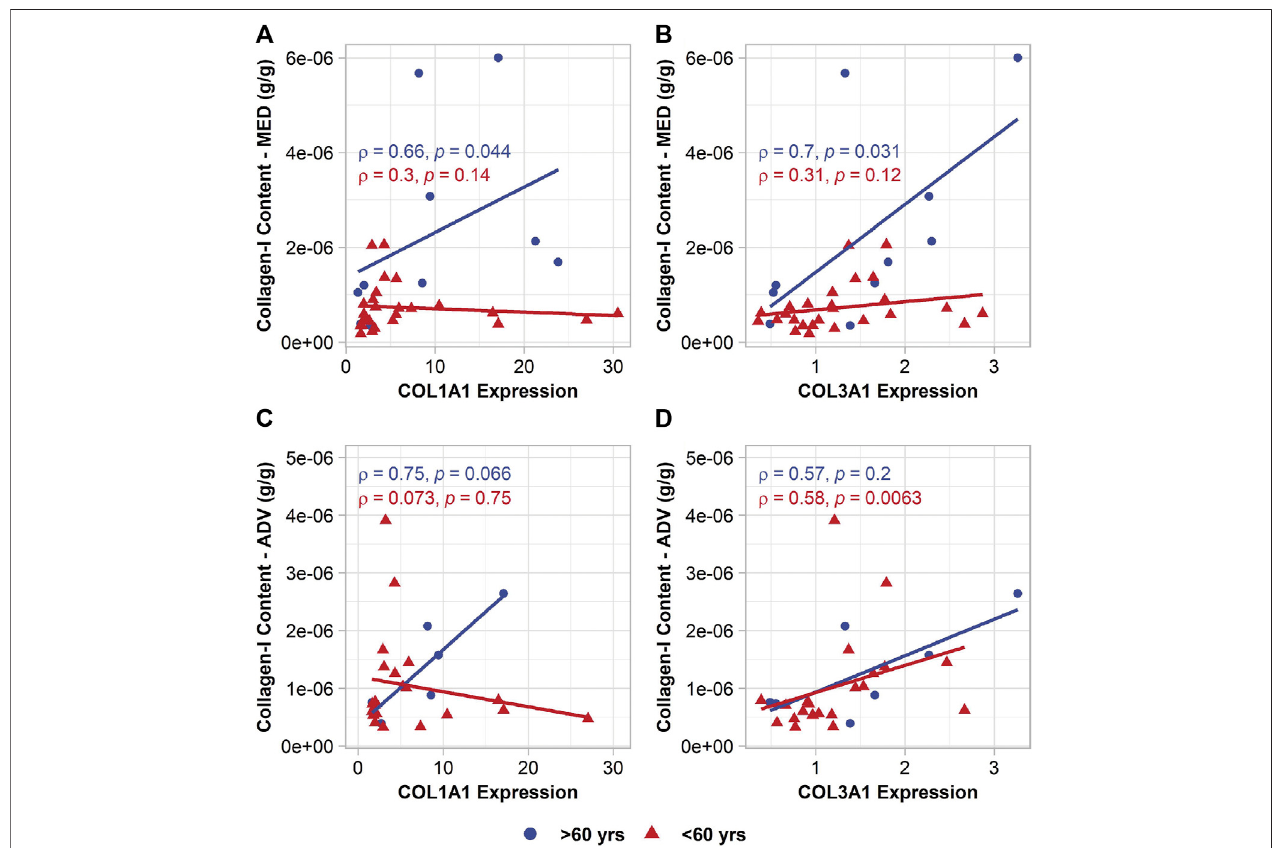
FIGURE 5 | Age-group speci fi c relationships between VSMC collagen gene expression and collagen-I content in the media (top row) and collagen-I content in the adventitia (bottom row). (A,C) COL1A1 expression; (B,D) COL3A1 expression.